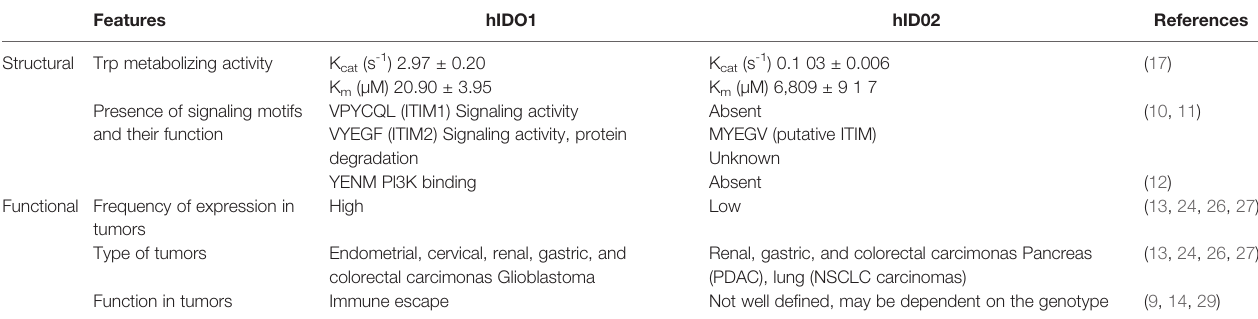
TABLE 2 | Main structural and functional features of human IDO1 and IDO2.